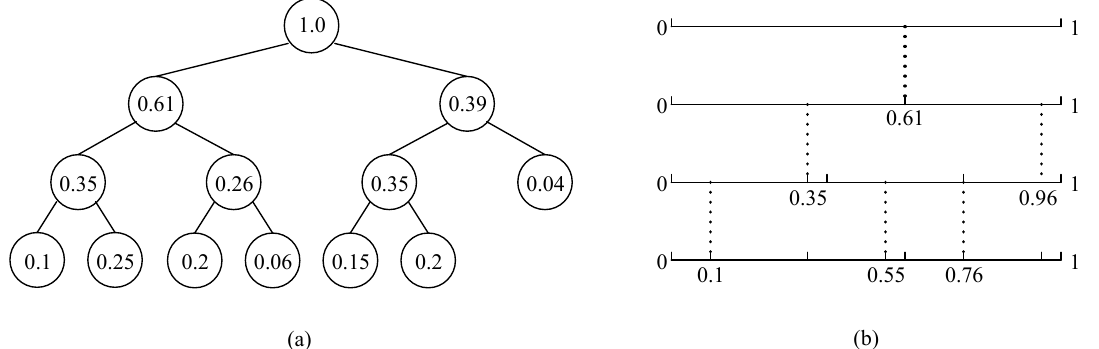
Figure 1. The relation between weighted tree and interval division. ( a ) is the random weighted tree, ( b ) is the weighted random interval division.